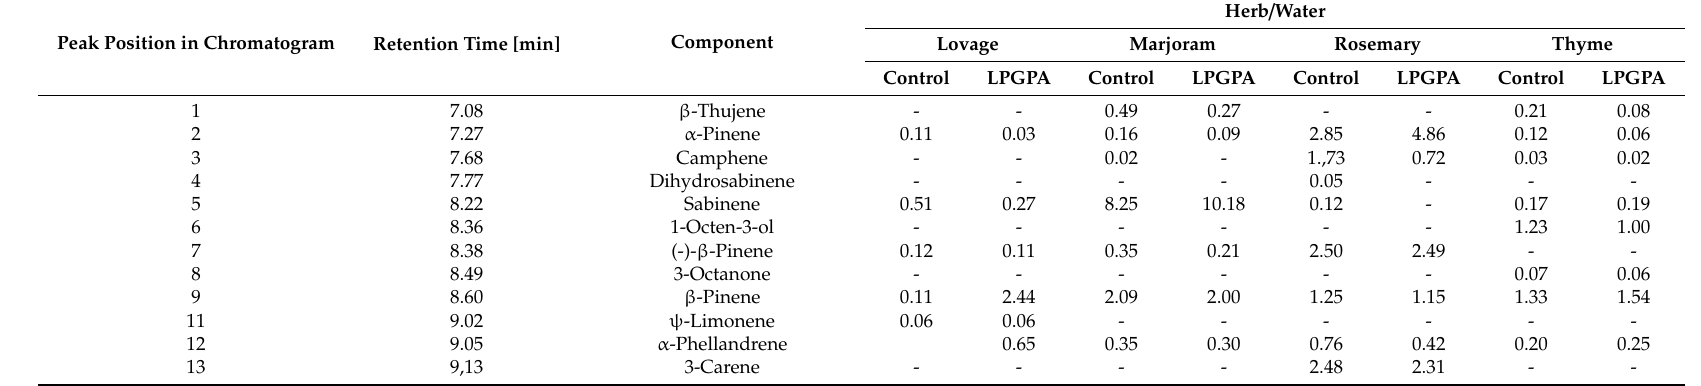
Table 2. Yield and composition of essential oils extracted from herbs watered with nontreated water (control) and